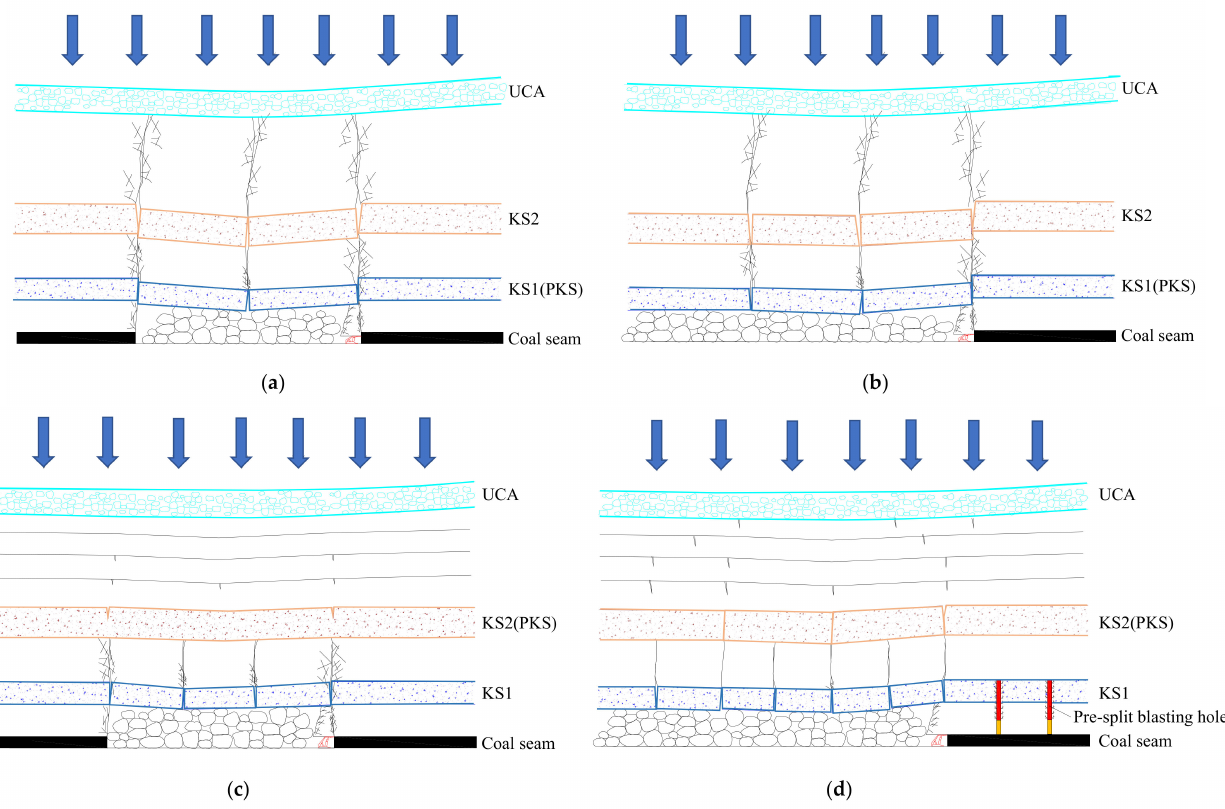
Figure 12. Sketch about mechanism of roof pre-split blasting measure to SCWID: ( a ) first weighting without blasting; ( b ) periodic weighting without blasting; ( c ) first weighting using blasting; ( d ) periodic weighting using